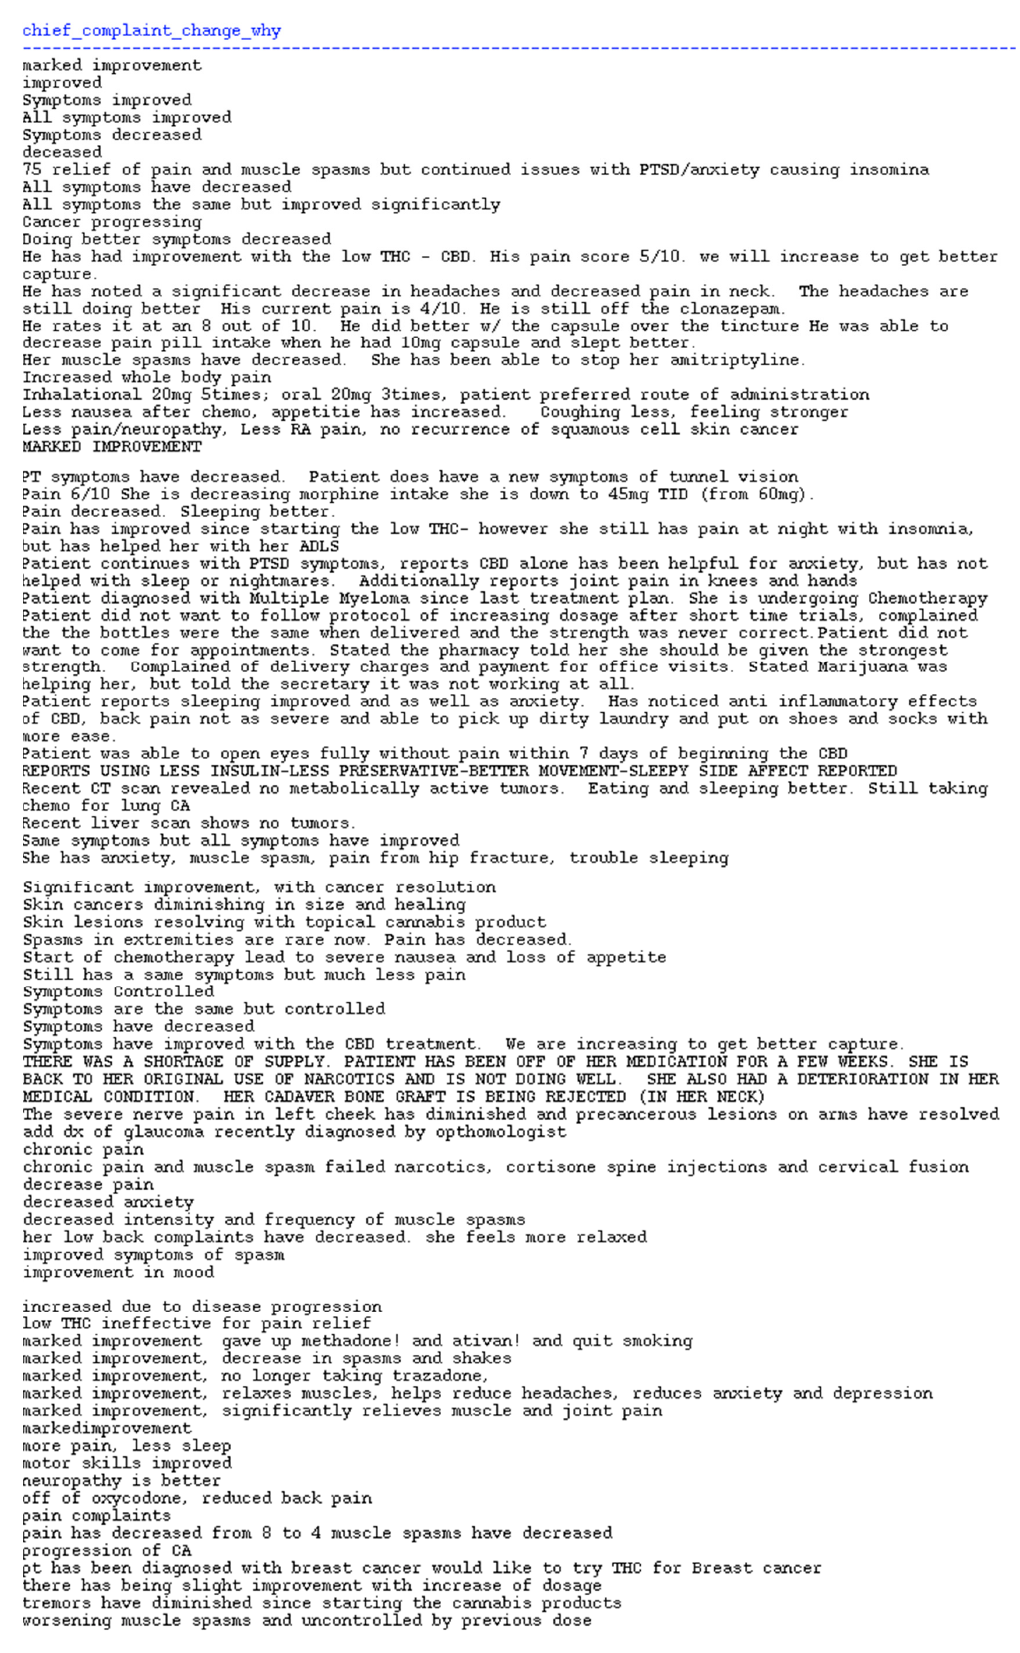
Figure A2. Changes in the Original Chief Complain / Indicated Condition During Follow-Up Visits; N = 95 entries.